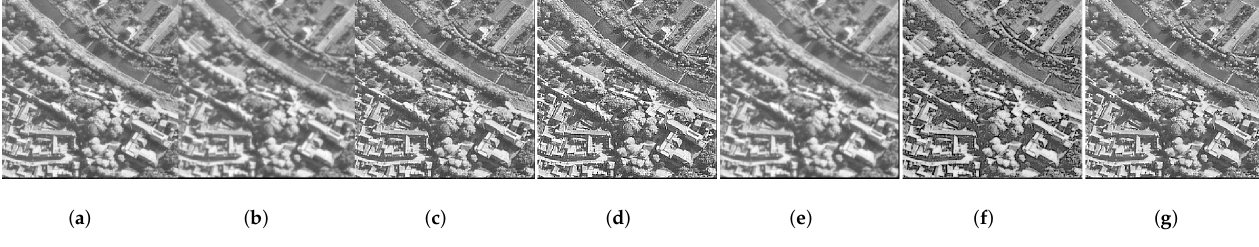
Figure 10. The renderings of street image under different algorithms. ( a ) Original image. ( b ) 1-order.